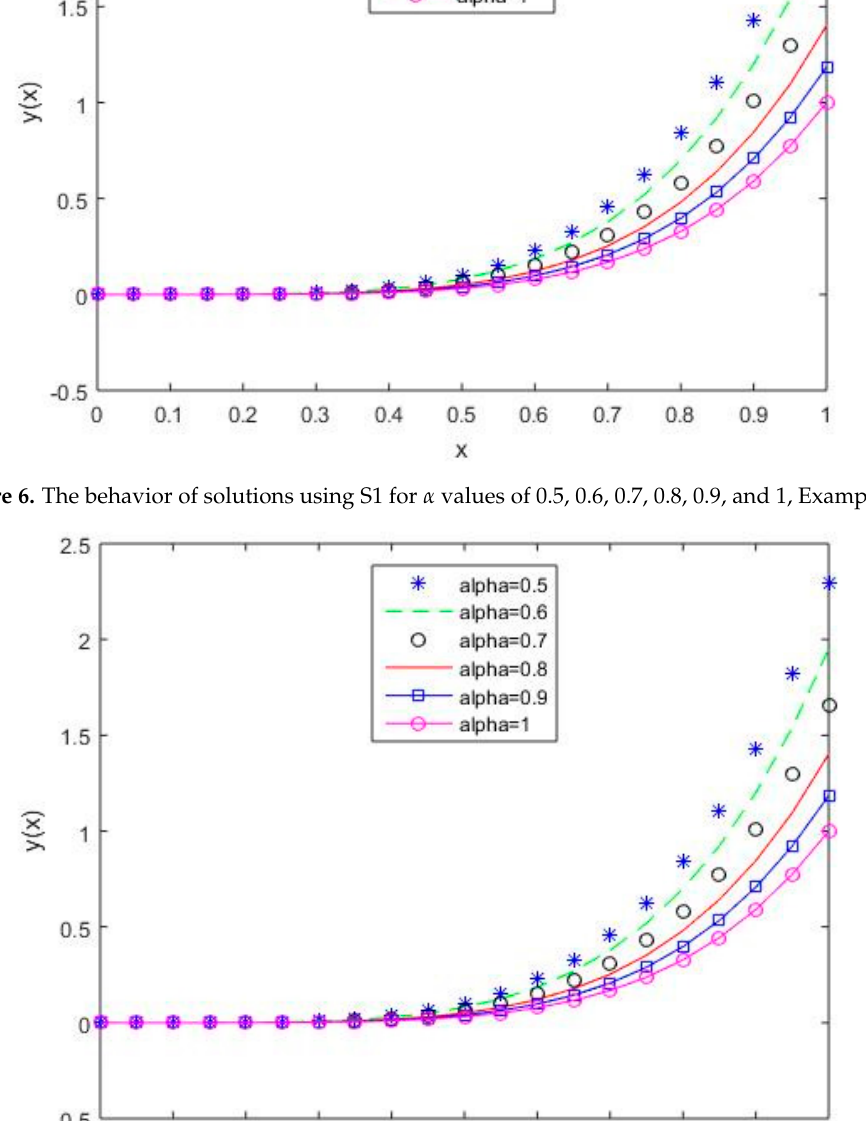
Figure 7. The behavior of solutions using S2 for α values of 0.5, 0.6, 0.7, 0.8, 0.9, and 1, Example 1.